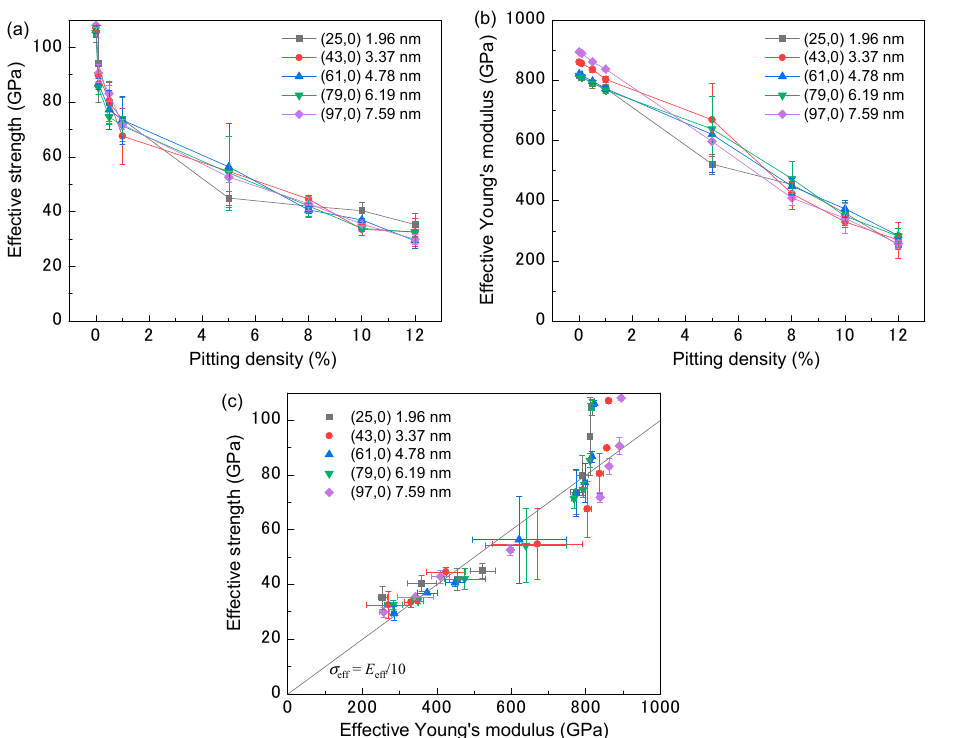
Figure 2. Numerical data indicating trends in ( a ) effective strength and ( b ) Young’s modulus. ( c ) Relationship between effective strength and Young’s modulus. The line in ( c ) indicates ideal strength with respect to the effective modulus, approximately one-tenth of the Young’s modulus.